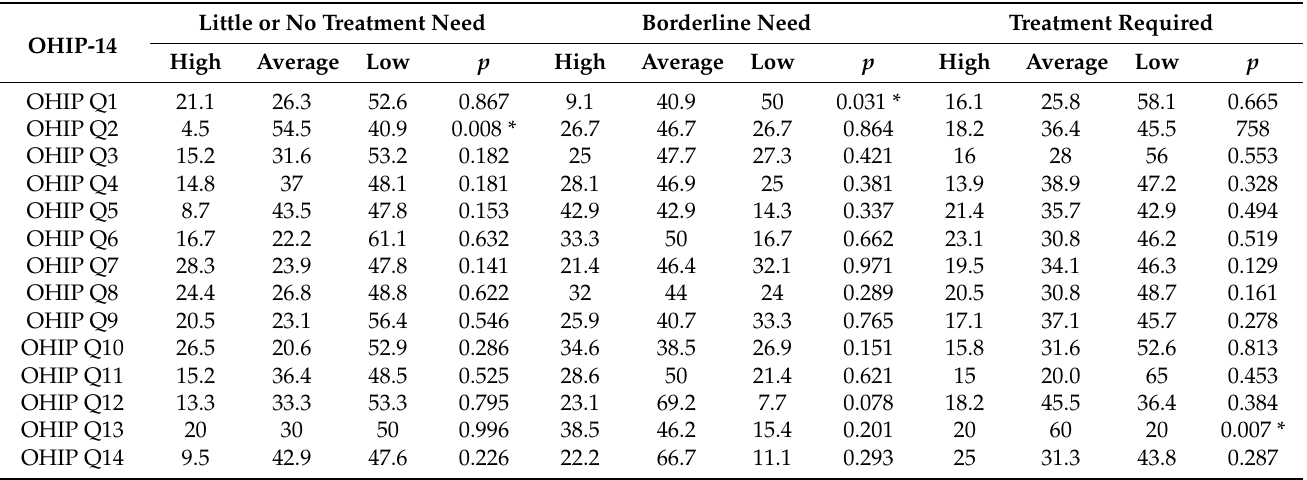
Table 8. Frequency of impact (in %) of each item of the OHIP-14 on IOTN-DHC in relation to the family income of the study participants (N =